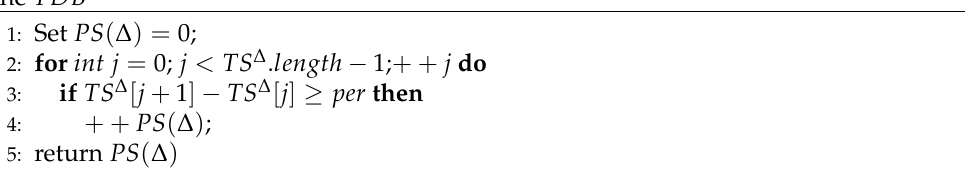
Algorithm 5 Calculate period support: TS ∆ , a list of time stamps that contained ∆ in the